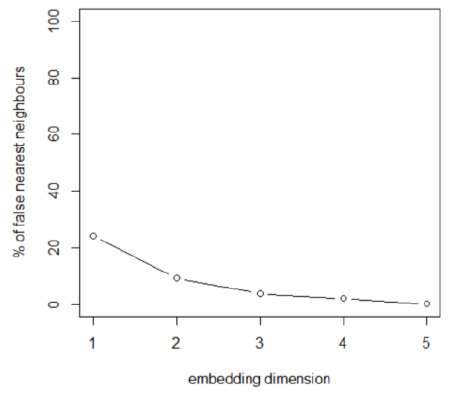
Figure 8: False nearest neighbours-Global food index; Source: